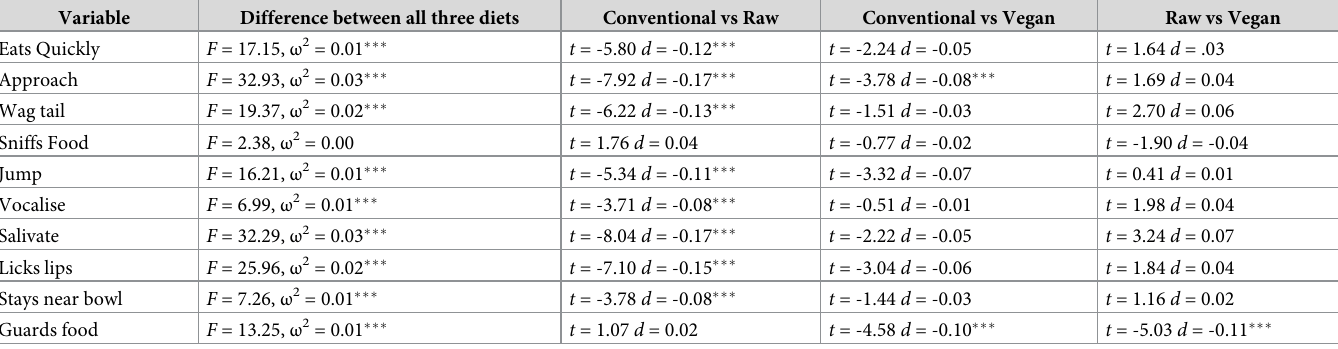
Table 3. Comparison between diet groups for the owner-reported food-oriented